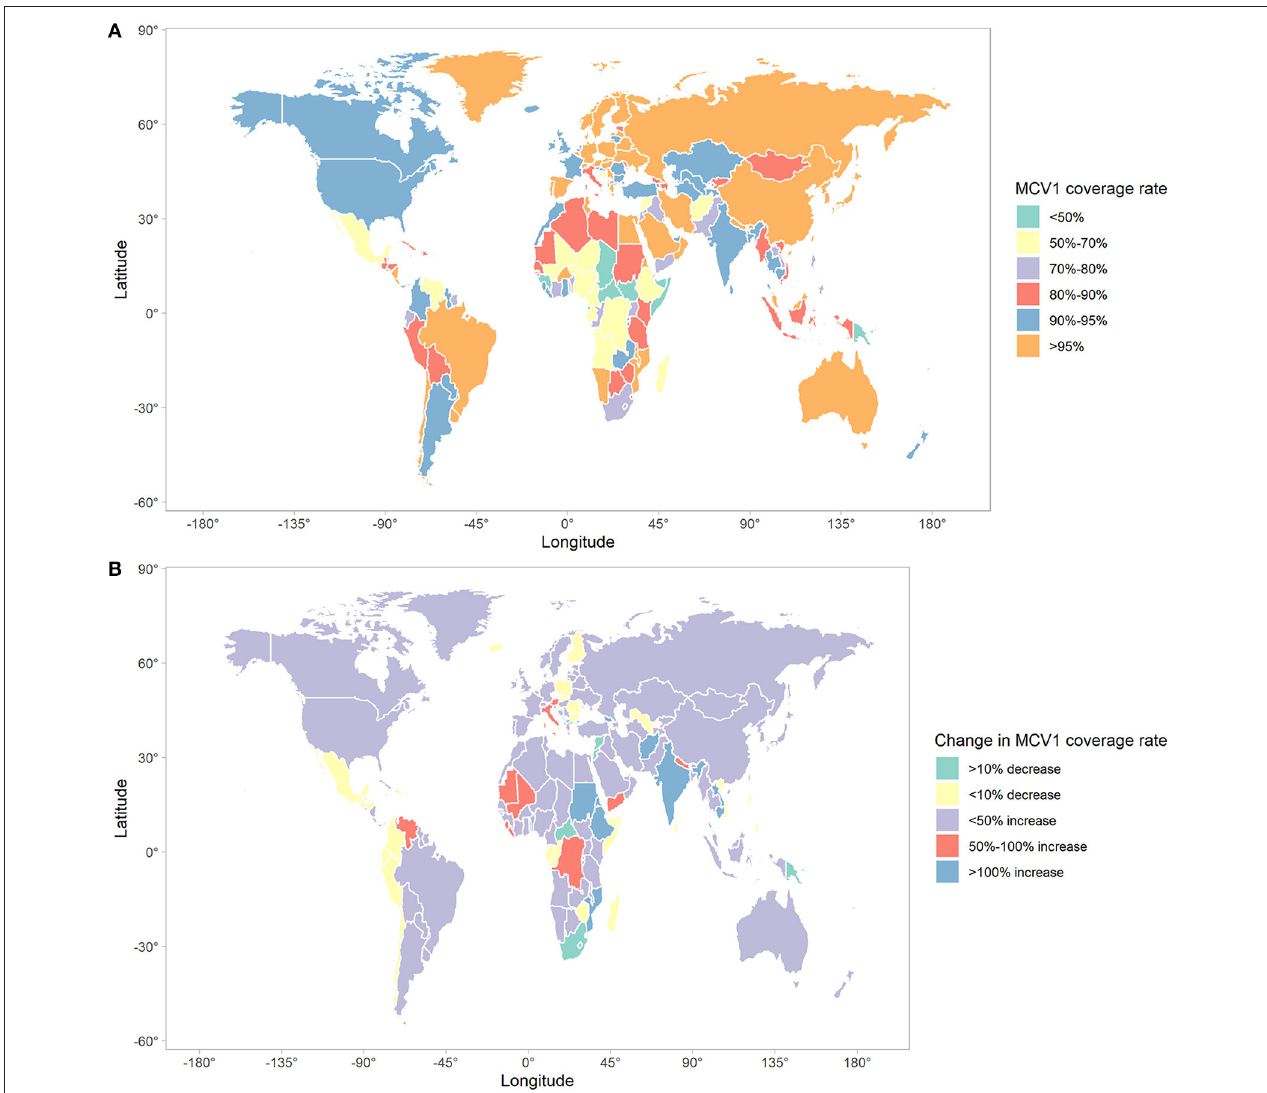
FIGURE 4 | The global trends in MCV1 coverage in 204 countries and territories. (A) MCV1 coverage rate in 2019; (B) changes in MCV1 coverage rate between 1990 and 2019. MCV1, measles-containing vaccine, dose